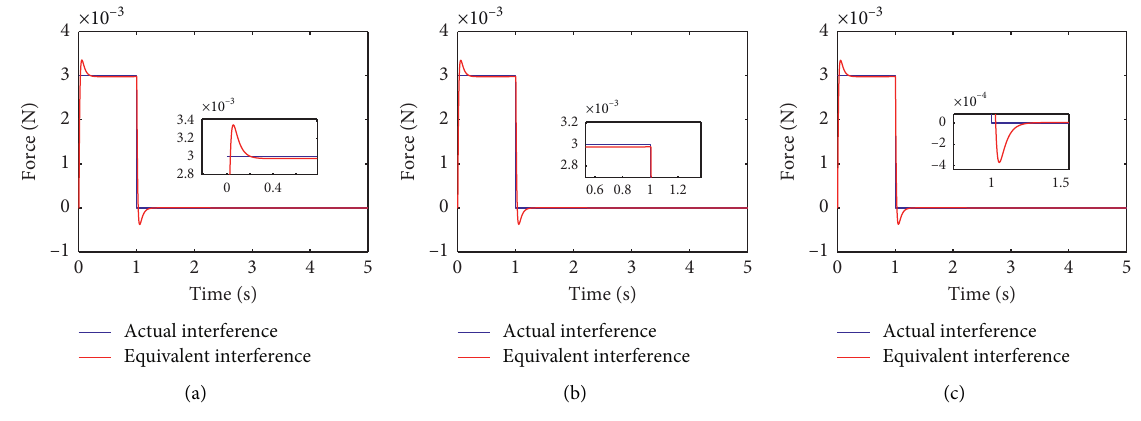
Figure 12: Test results of disturbance observer: (a) f